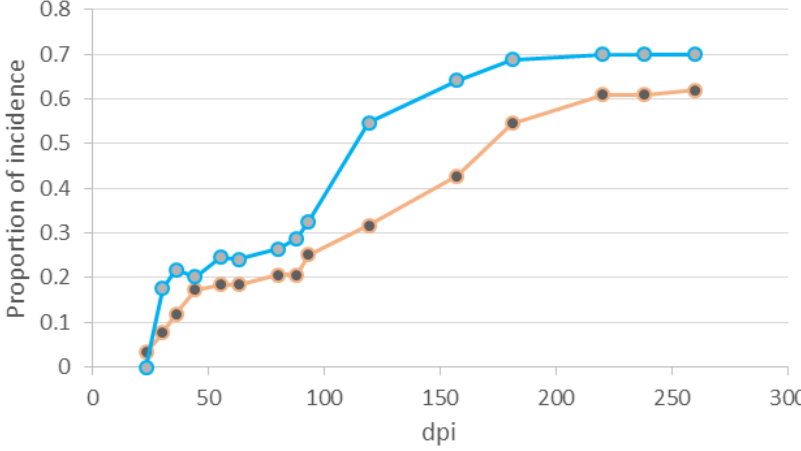
Figure 5. Disease progress curve on seedlings of P. radiata grown from seeds externally inoculated with 10 4 spores/mL of F. circinatum . Each curve is the mean of three replicates in each experiment repetition (repetition 1 for orange curve and repetition 2 for blue curve). Dpi means days post